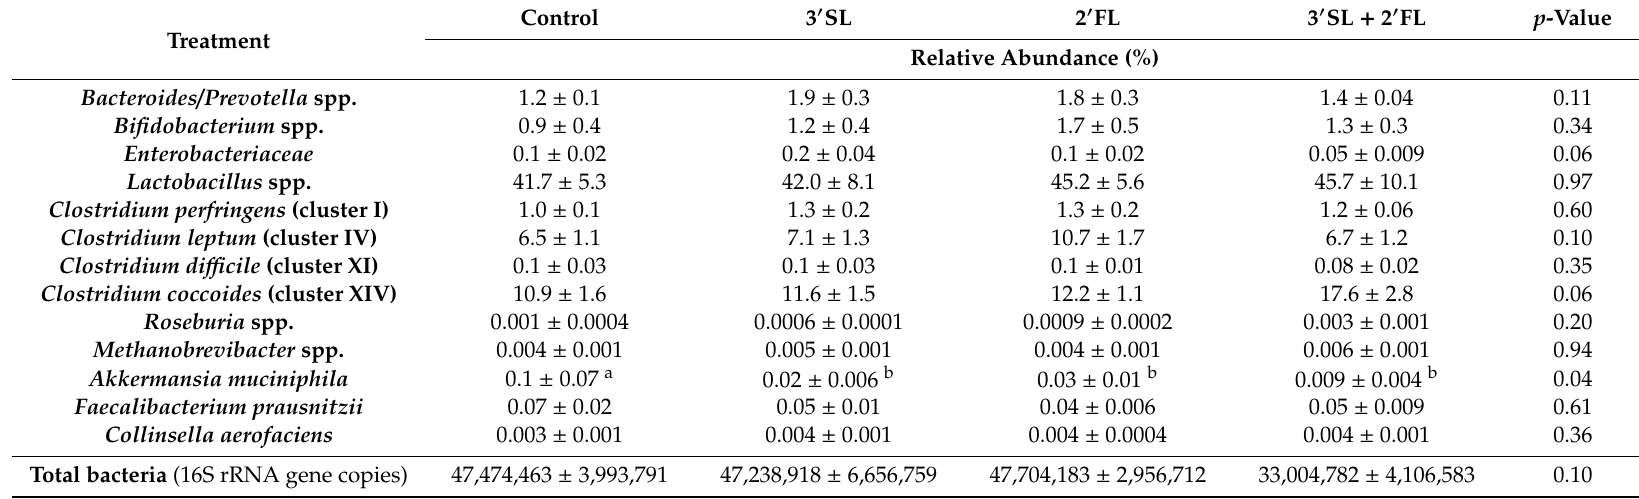
Table 2. Relative abundance of fecal microbiota (qPCR) in female rats at seven weeks of age fed the AIN-93 diet fortified with 3 (cid:48) SL, 2 (cid:48) FL, both, or neither. Control 3 (cid:48) SL 2 (cid:48) FL 3 (cid:48) SL + 2 (cid:48) FL p -Value Treatment Relative Abundance (%) Bacteroides / Prevotella